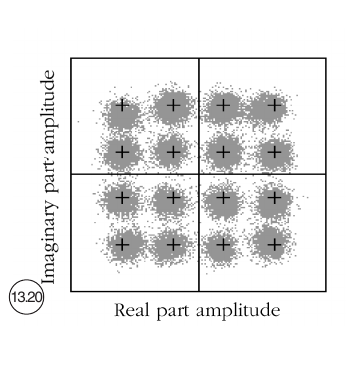
Fig. 13.19. Four channel acquisition. Fig. 13.20. Constellation at the output of the spatial